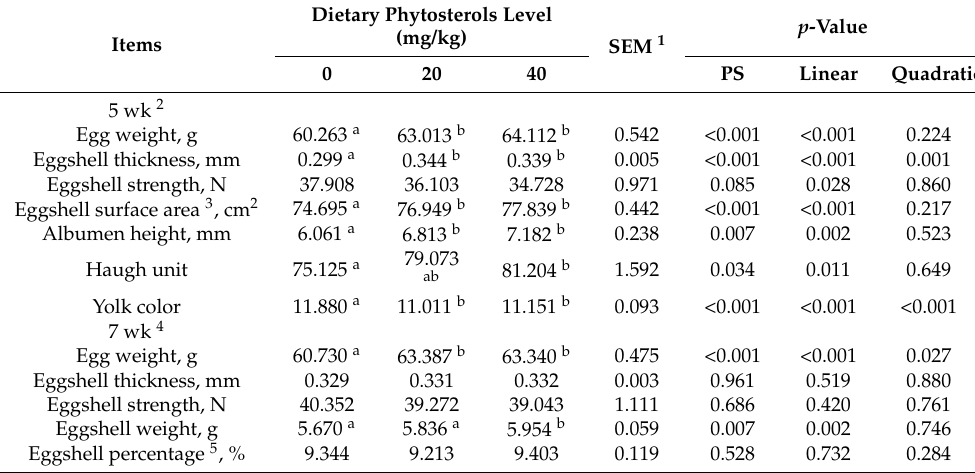
Table 3. Effects of dietary phytosterols on egg quality in aged laying hens.